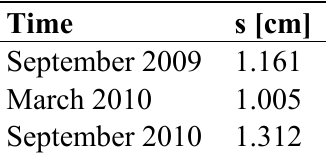
Table 1. Results from the roughness